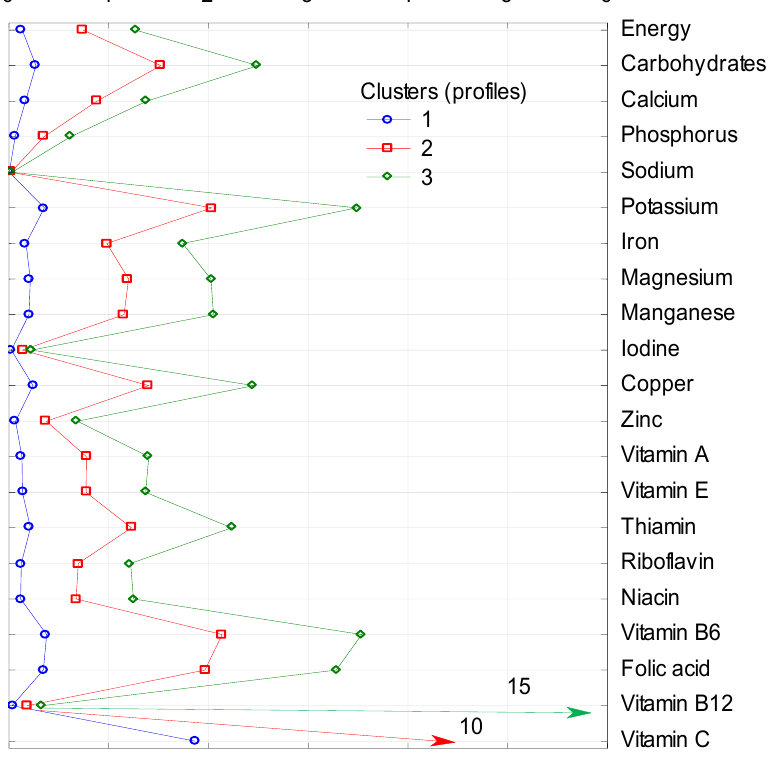
Figure 2. Cluster analysis: supply of energy and analyzed nutrients (in %) from the subgroup of vegetable juices and mixed to diets in individual clusters. 1, 2, 3 — number of clusters; characteristics of clusters are presented in Table 3.